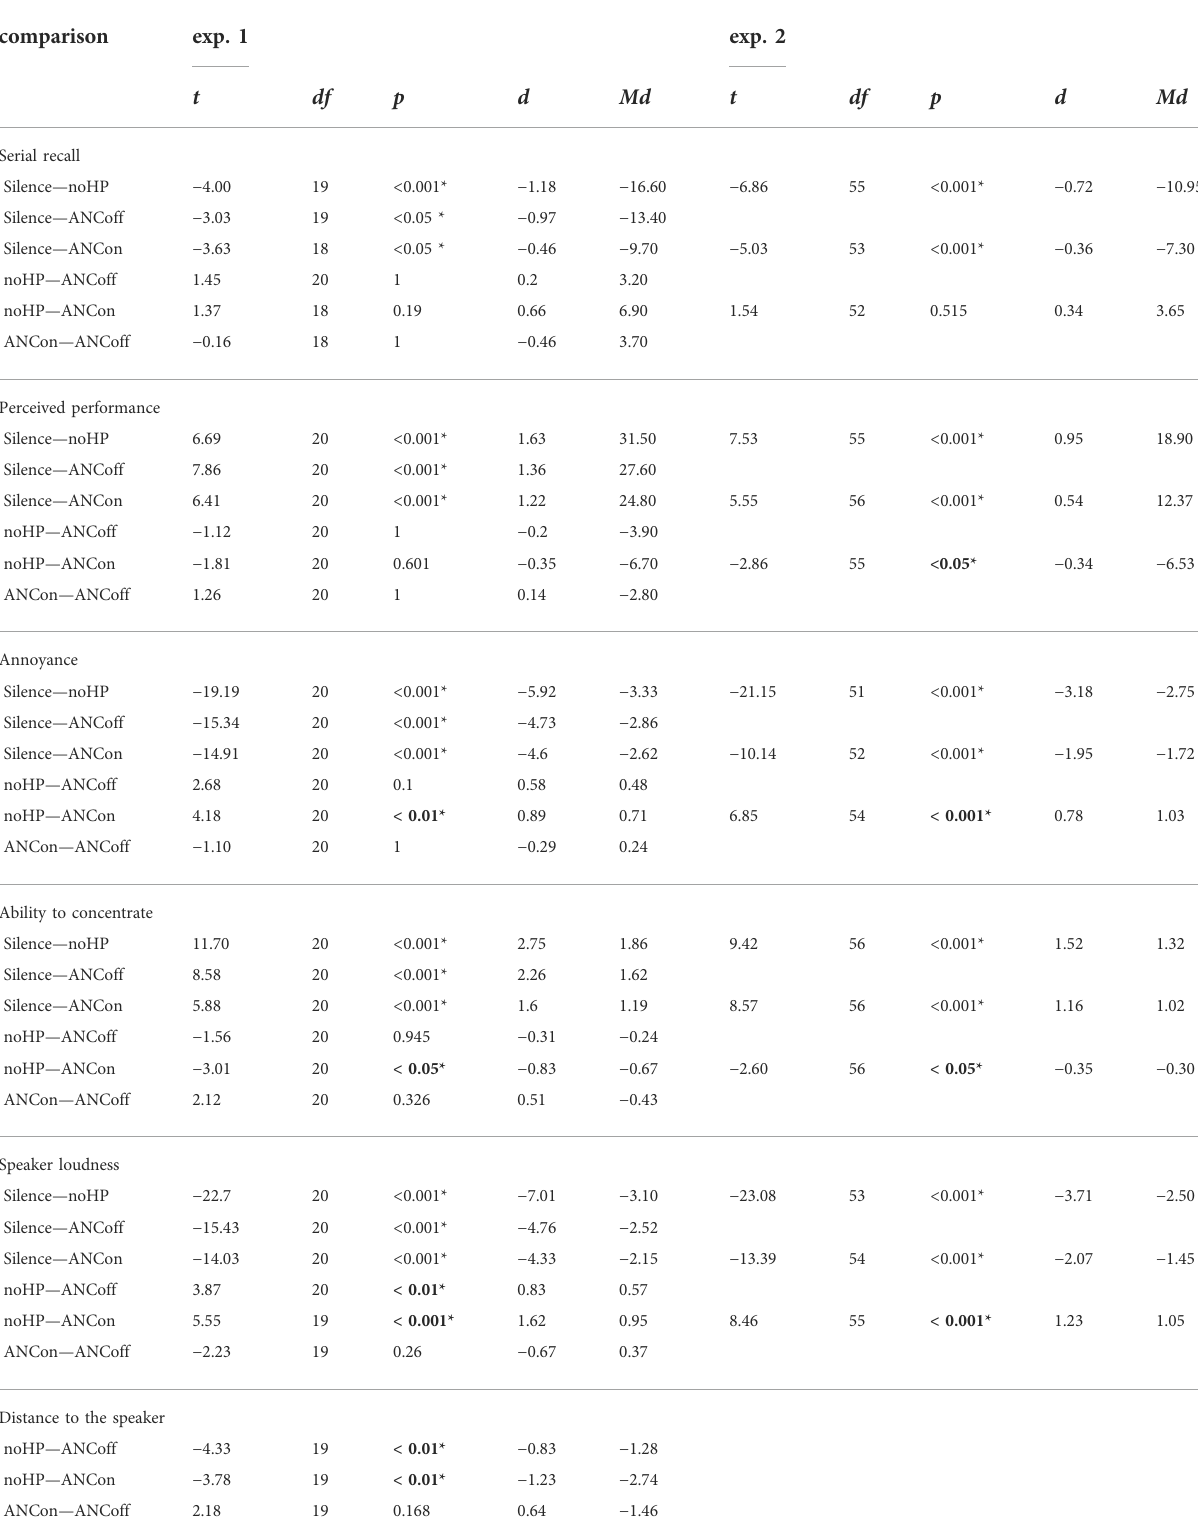
TABLE 1Overview oft-tests ofmean error ratesin the serial recall as wellas of the subjective assessments during the different soundconditions with adjusted p -values(Bonferroni-correction) andCohen ’ sdeffectsizeaswellasthemeandifferences(Md)anddegreesoffreedom(df).Statistically signi fi cant fi ndings except for tests against silence are indicated in